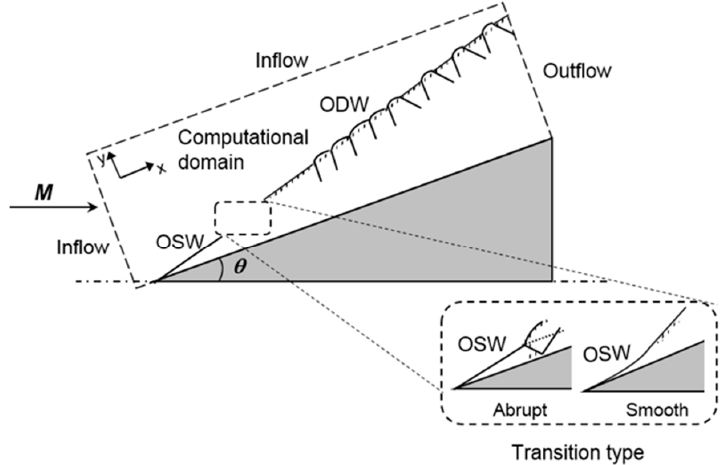
Figure 1. A schematic of the computational details and oblique detonation wave (ODW) phenomena. OSW: oblique shock wave.